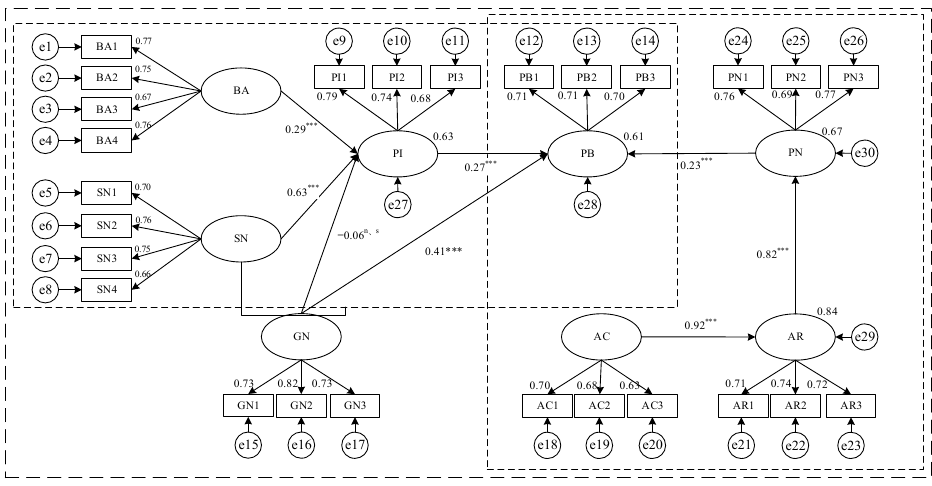
Figure 4. Competing model 3: the integrated model of TPB-NAM. Note: *** is significant at 1%. ns means not significant. Robust standard error in